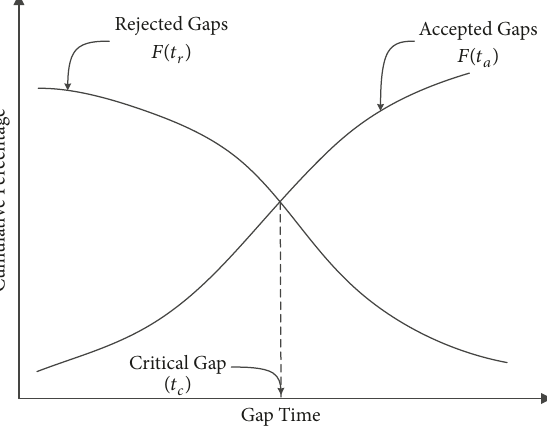
Figure 2: Critical gap based on Raff’s